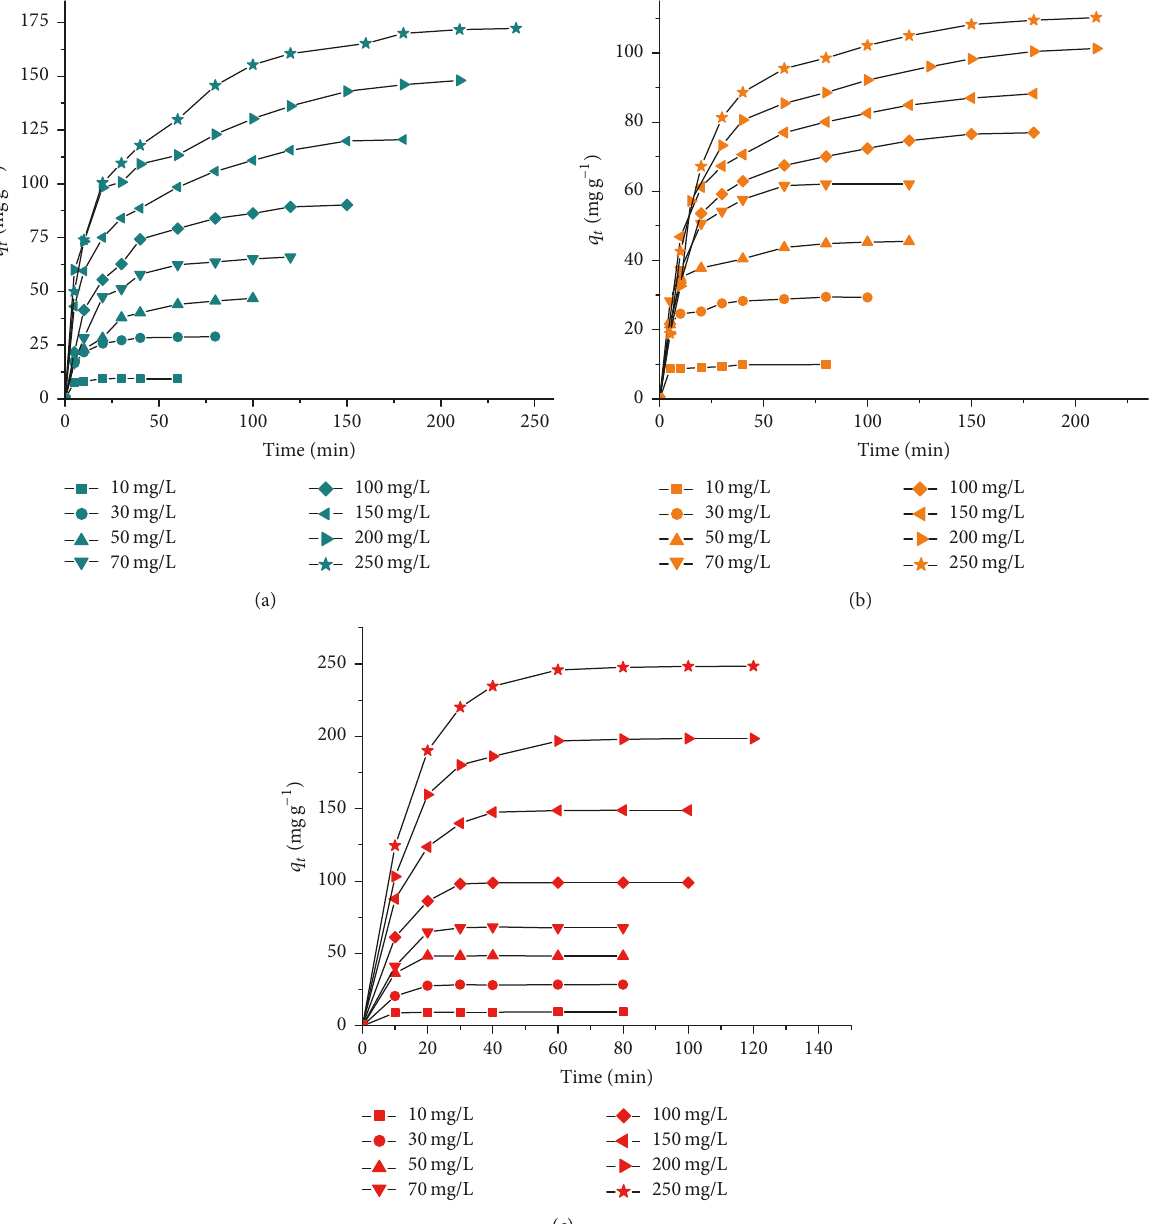
Figure 6: The effect of initial concentration on (a) NB, (b) ChS, and (c) BR2 dyes removal (1g L −1 PM-4, 25 ∘ C, pH 7.4 for NB, 7.1 for ChS, and 6.7 for